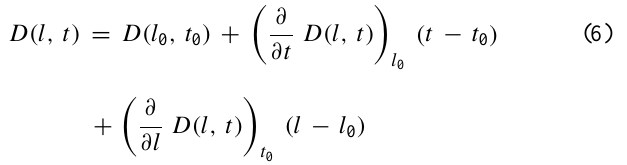
The westward drift ( 1 long/ 1 yr) of declination is the ratio between the declination variation vs. time ( 1 decl/ 1 yr) be- tween 1825 and 1962 (we consider the 0.101 ± 0.003 ◦ yr − 1 value calculated from 1840 to 1960, Fig. 2), and the average 0.22 ± 0.12 1 decl/ 1 long value calculated from Fig. 5. We eventually get a specific value of 0.46 ± 0.19 ◦ yr − 1 westward drift value for the Mediterranean region post-1825 declina- tion values, which is statistically undistinguishable from both the 0.38 ± 0.07 ◦ yr − 1 global value calculated by Merrill et al. (1996) for the last two millennia, and the 0.61 ± 0.08 ◦ yr − 1 value calculated by Barraclough and Malin (1999) for the European declination minimum of 1750–1860. We have modified the years of the relocated directions of Fig. 2 taking into account the 0.46 ± 0.19 ◦ yr − 1 westward drift value calculated above (Fig. 6). All relocated and west- ward drift-corrected data are listed in Database S3 (see Sup- plement). Italian declinations are again in gross agreement with those derived from the JM2000 and PM2009 models, and the discrepancy of declinations measured in Italy in 1640 with respect to declination derived from JM2000 is reduced. Surprisingly, the shift of declinations data from Castellac- cio gathered at 1933–1962 (with respect to both other Italian data and JM2000, Fig. 2) is annulled. We conclude that the mismatch of declination data from Castellaccio, as evident in Fig. 2, is entirely due to the westward drift of the geomag- netic field, and no other factors (such as errors arising from data relocation via the pole method or local/crustal magnetic anomalies) are involved. Inclination data corrected for the westward drift (Fig. 6) show a better agreement than non-corrected data of Fig. 2 with respect to JM2000 and PM2009, though inclination dif- ferences for pre-1800 and post-1900 years persists. A simi- lar 1 ◦ –2 ◦ difference exists between the inclination relocated from the measurement of 1640 of Rome by Kircher, and the coeval inclinations calculated by the JM2000 and